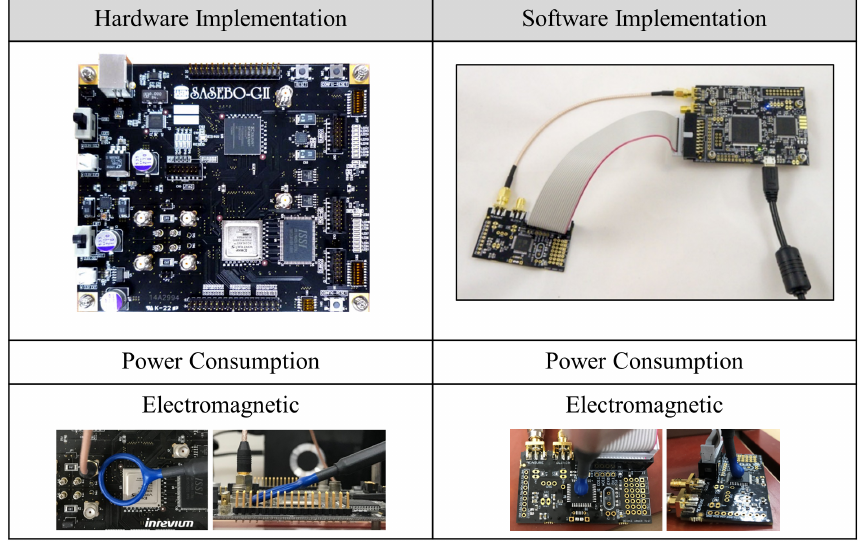
Figure 7. Key bit-dependent attack experiment